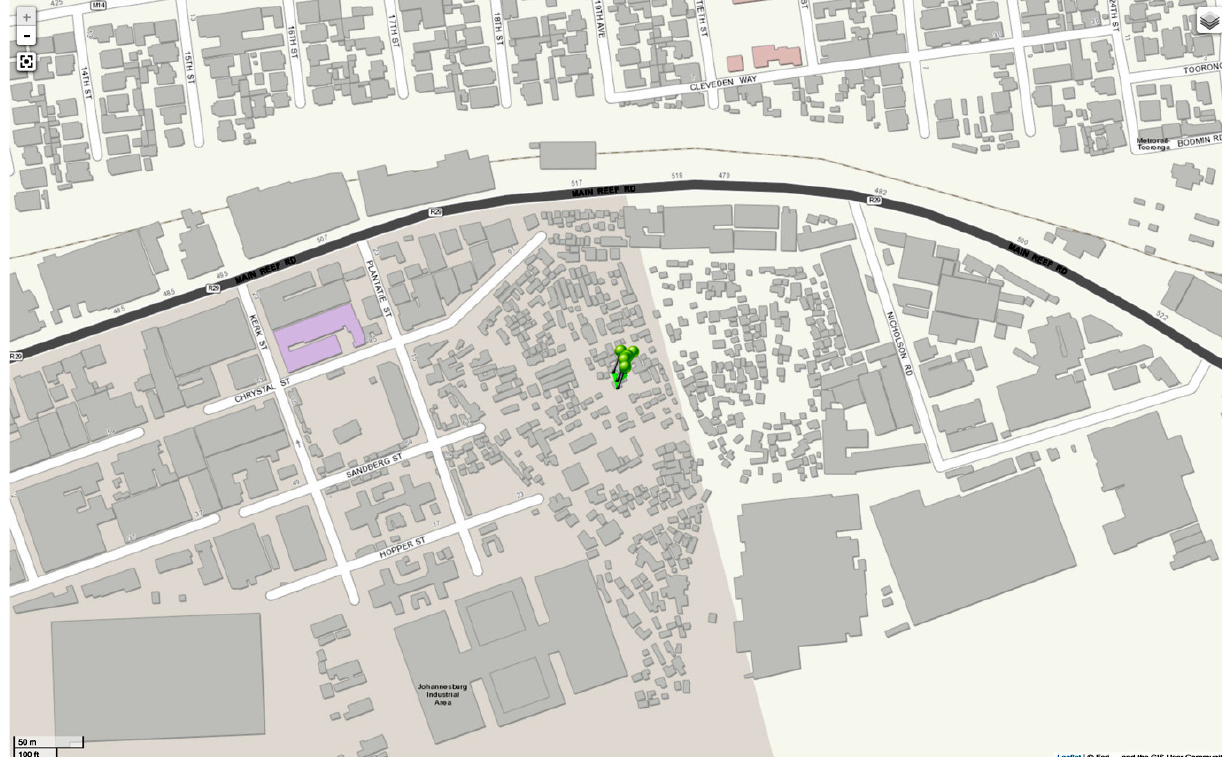
Figure 6. The presence of “markers” without connecting lines represents a day in which this Denver participant did not move more than 20 m from her initial location. Source: Map by Chantal Bekkering,